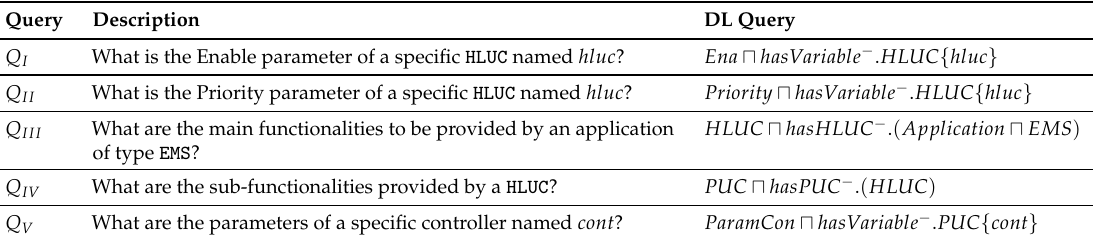
Table 9. Querying the EMS- ABox .